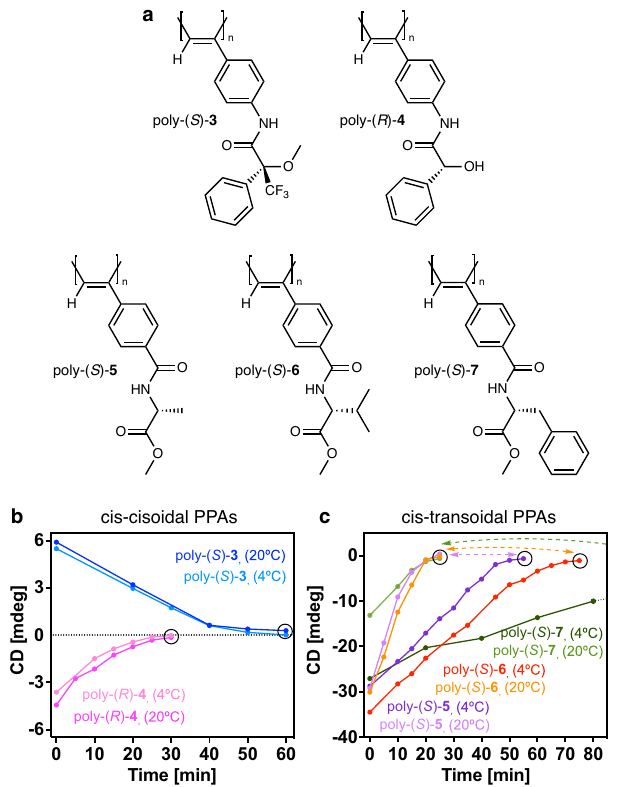
Fig. 3 | Structures of cis-cisoidal and cis-transoidal PPAs and ECD signal decay vs.time.a Chemicalstructureofpoly-( S ) − 3 , poly-( R ) − 4 , poly-( S ) − 5 , poly-( S ) − 6 and poly-( S ) − 7 . b ECD signal decay vs. time for poly-( S ) − 3 (THF, CD@386nm at 20 and 4°C,pinkandlightpinklines,respectively)andpoly-( R )- 4 (THF,CD@386nmat20 and4°C,blueandlightbluelines,respectively)atdifferentirradiationtimesunder visible light at two temperatures. c Idem for poly-( S )- 5 (CHCl 3 , CD@368nm at 20 and 4°C, light purple and purple lines, respectively), poly-( S )- 6 (CHCl 3 , CD@367 nm at 20 and 4°C, orange and red lines, respectively) and poly-( S )- 7 (CHCl 3 , CD@368nmat20and4°C,lightgreenandgreenlines,respectively).[poly-( S ) − 3